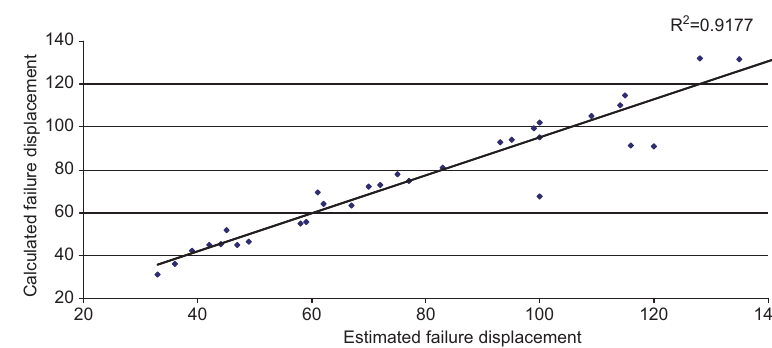
Figure 5 Comparison of pushover and ANN results for failure displacement ( δ failure) of RC structures.